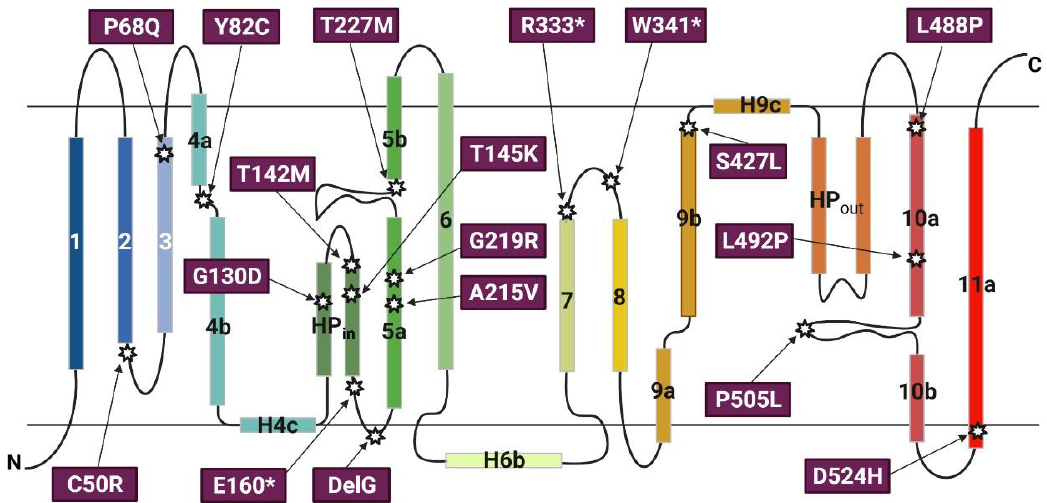
Figure 4. Transmembrane topology of SLC13A5 and the localization of selected non-synonymous single nucleotide variants (SNVs). The transmembrane topology structure of SLC13A5 was adopted from Sauer et al. The 11 transmembrane helices are shown as numbered rectangles; the hairpin loop is labelled HP. The localization and amino acid replacement of selected SNVs previously reported as “pathogenic” are indicated. * Represents nonsense mutations.